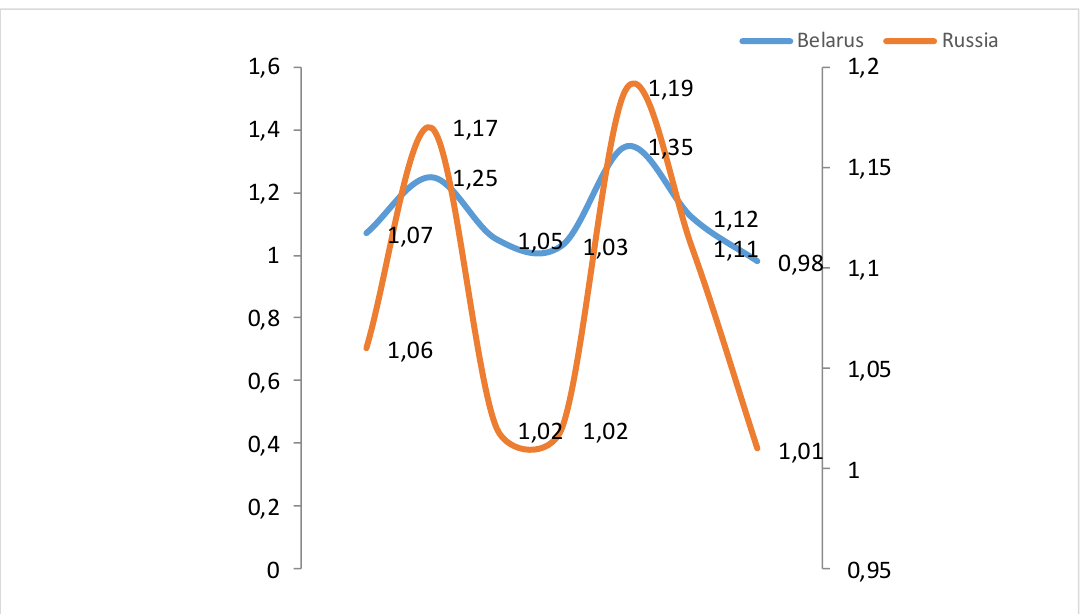
Figure2: Dynamics of constituent elements of neo-industrialization vector in